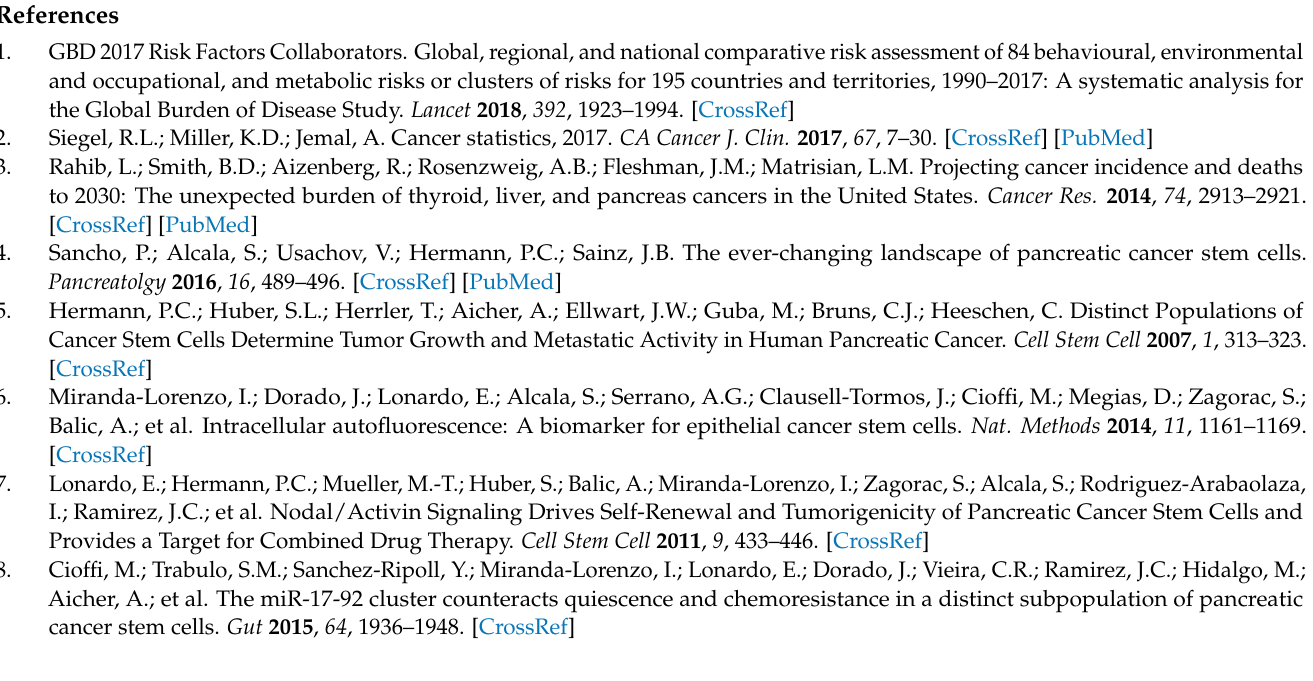
Figure S2: mDivi-1 decreases cell viability in normoxia; Figure S3: mDivi-1 disrupts mitochondrial function; Figure S4: Treatment effects of mDivi-1 on cellular